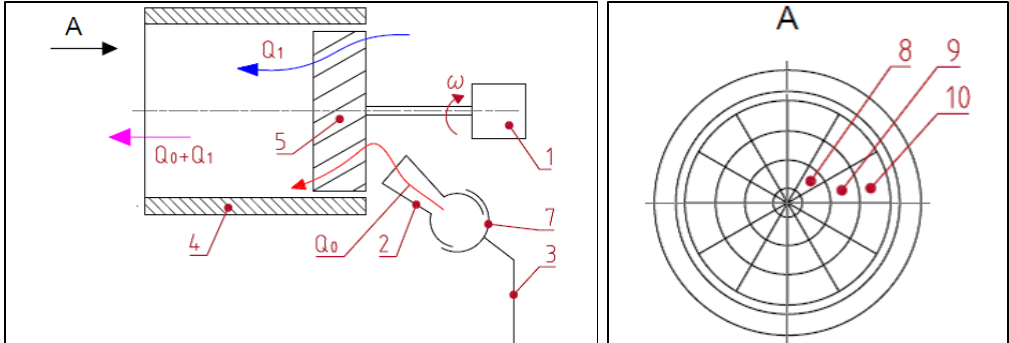
Figure 16. A hybrid mesh turbine schematic: 1- generator; 2- nozzle block; 3- working gas source; 4- casing; 5- impeller; 7- velocity vector control system; 8, 9, and 10- annular flow channels in which the blades are